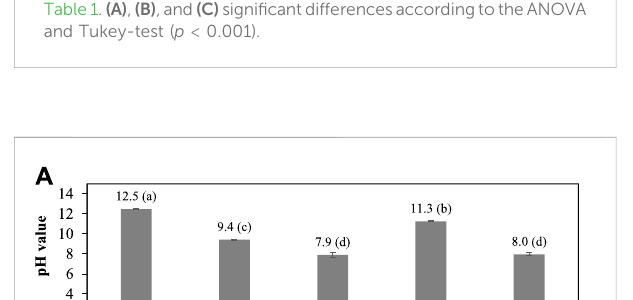
FIGURE 5 Bulk density (n = 5) of each of the tested substrates. Values are presented as means ± standard deviation. For the treatments refer to Table1. (A) , (B) ,and (C) signi fi cantdifferencesaccordingtotheANOVA and Tukey-test ( p < 0.001).